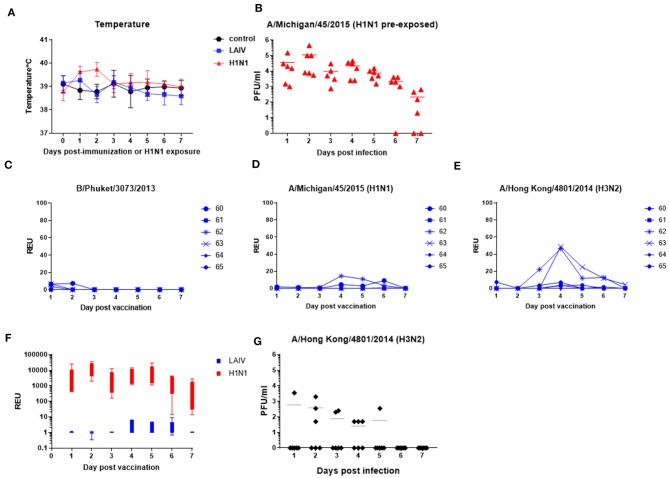
Vaccine and wt virus replication in nasal swabs. Pigs were immunized with LAIV or infected with wt H1N1. Control were untreated animals. Nasal swabs and temperatures were taken daily. (A) Temperatures after LAIV immunization or wt H1N1 pre-exposure. (B,G) Virus shedding in nasal swabs in wt H1N1-or wt H3N2 pre-exposed group determined by plaque assays. (C–E) RT-qPCR for the indicated virus components in the LAIV immunized animals. Each data point represents an individual within the indicated group. (F) Comparison of H1N1 virus shedding in LAIV immunized and wt H1N1 pre-exposed groups as determined by relative copies of H1 HA RNA. RNA quantity is expressed as Relative equivalent units (REU).